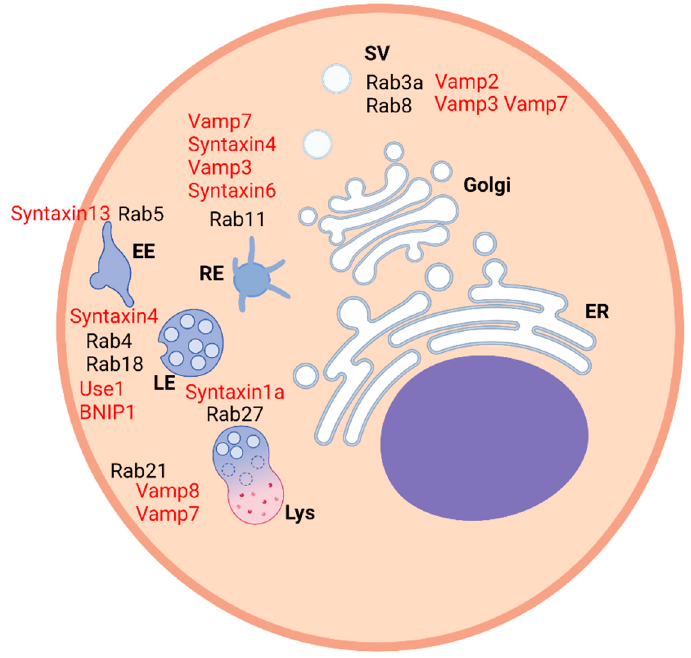
Figure 1. Scheme representing a generic animal cell. Rab proteins are located in the right compartments and the relative interacting SNARE proteins are labeled in red. EE—early endosome, RE—recycling endosome, LE—late endosome, Lys—lysosome, ER—endoplasmic reticulum, SV—secretory vesicle.